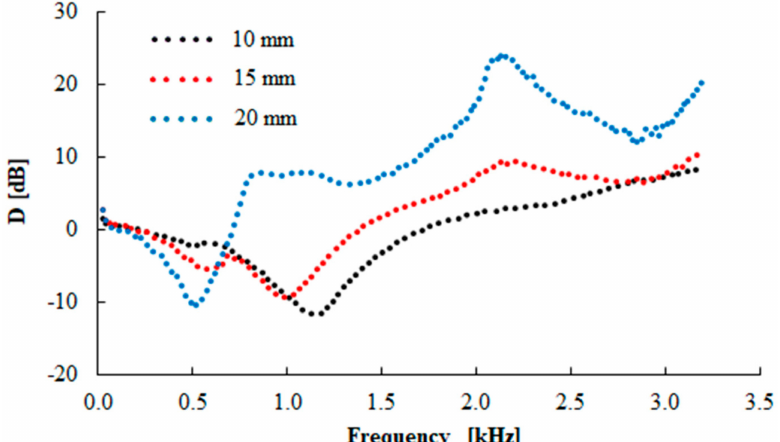
Figure 14. Frequency dependencies of the transfer damping function (D) for the tested N 330 rubber composites of di ff erent thicknesses and loaded with inertial mass m = 90